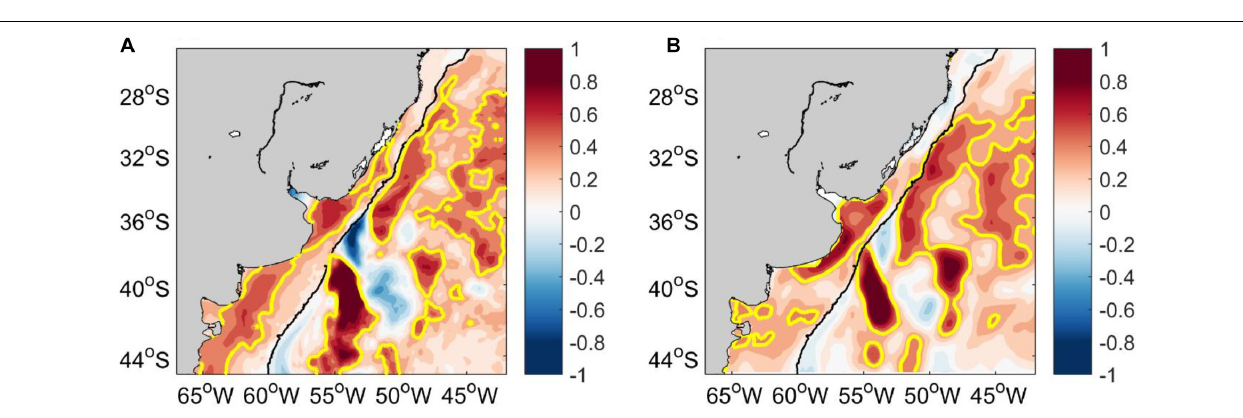
FIGURE 3 | (A) GLORYS12 and (B) ARMOR3D surface temperature trend ( ◦ C/decade) during 2003–2017. The yellow contour corresponds to the 0.4 ◦ C/decade isoline. The 200 m isobath is shown in